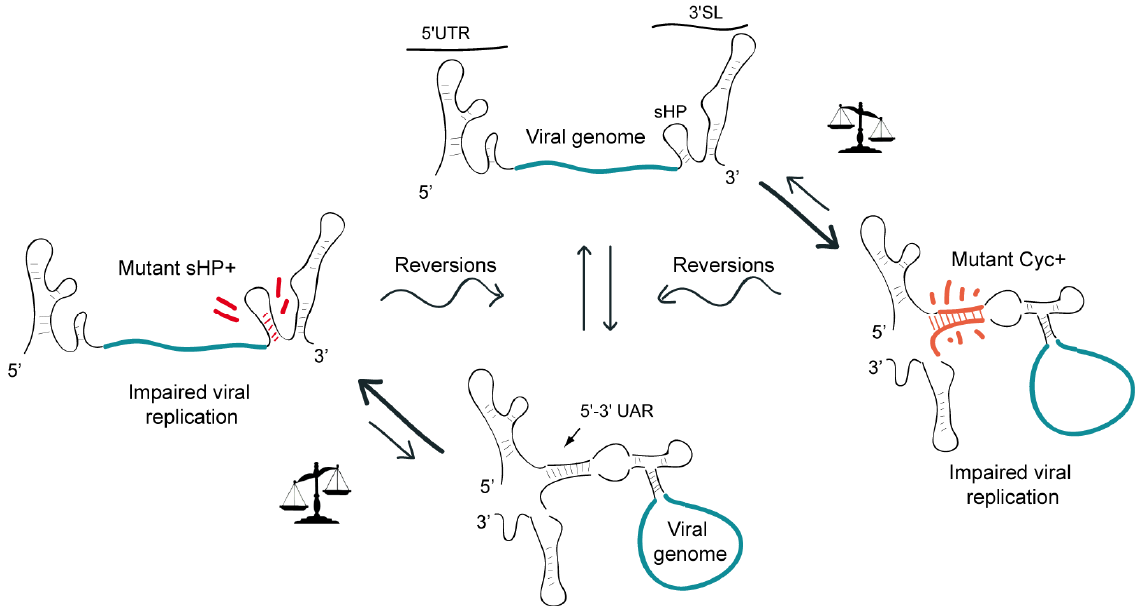
Figure 4. Representation of a model showing the requirement of a balance between different conformations of the DENV genome. Viruses carrying mutations that increase the stability of the circular or the linear form of the RNA, by increasing 5'-3'UAR complementarity (Mut Cyc+) or by stabilizing the sHP (Mut sHP+) respectively, evolve in culture incorporating spontaneous mutations that restore the relative stability of the two competing